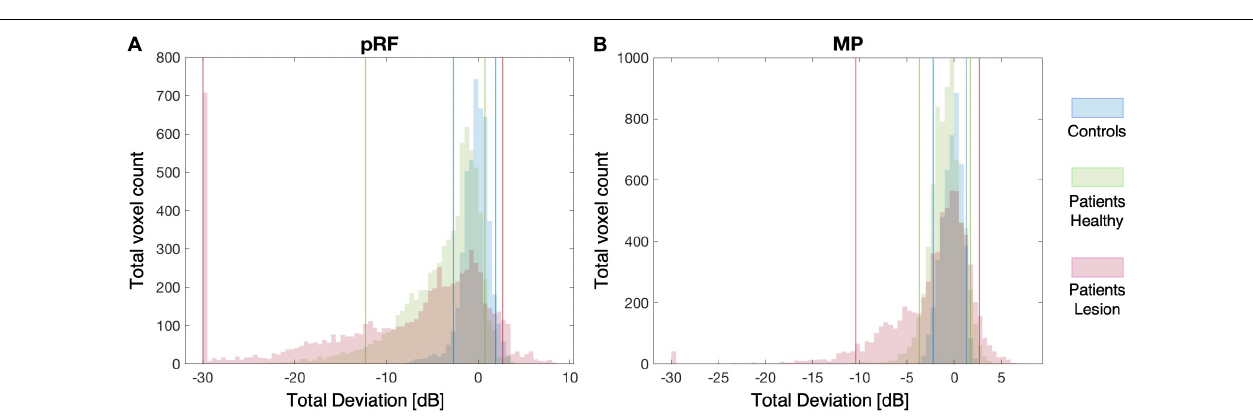
FIGURE 5 | Distribution plots of VF Sensitivity. The distribution of the VF sensitivities of both the controls and patients for the pRF mapping (A) and the MP (B) techniques. The solid blue, green, and pink lines indicate the 90% boundaries of VF sensitivity for the controls, patients’ healthy and patients’ lesioned hemisphere,